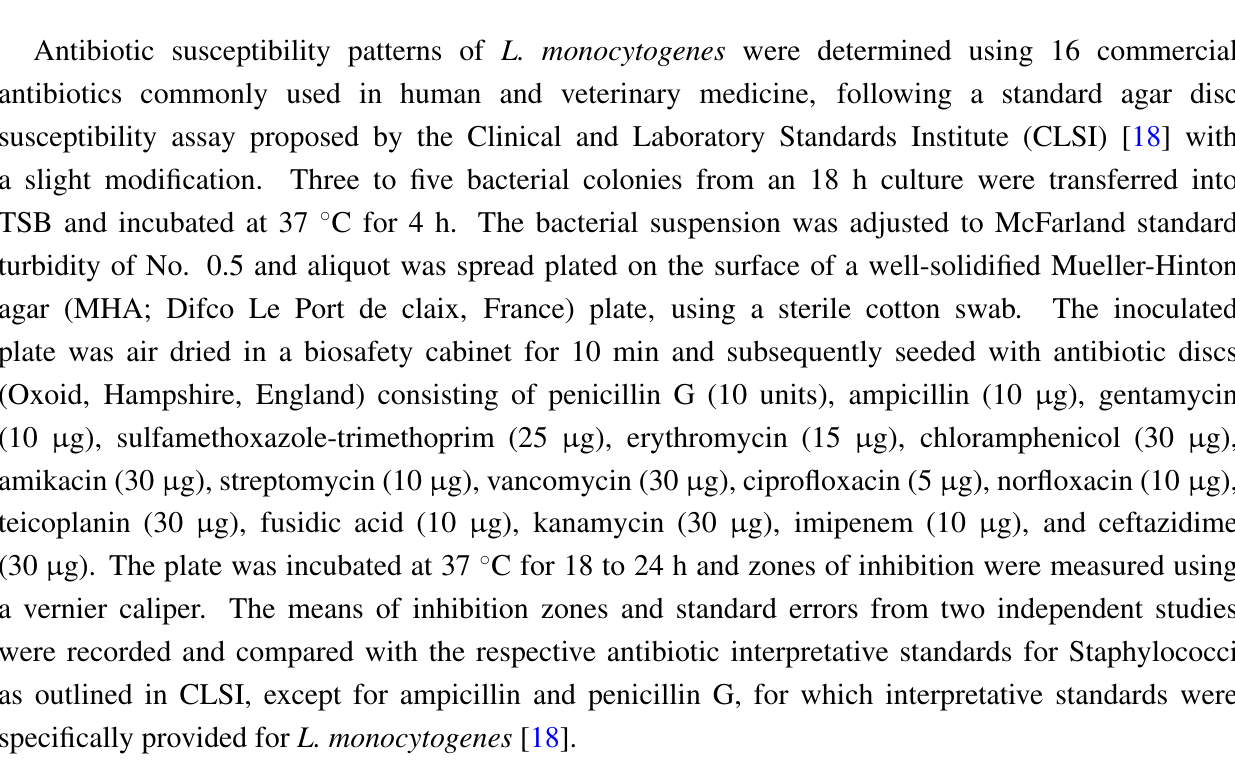
Listeria monocytogenes Using Agar Disc Diffusion